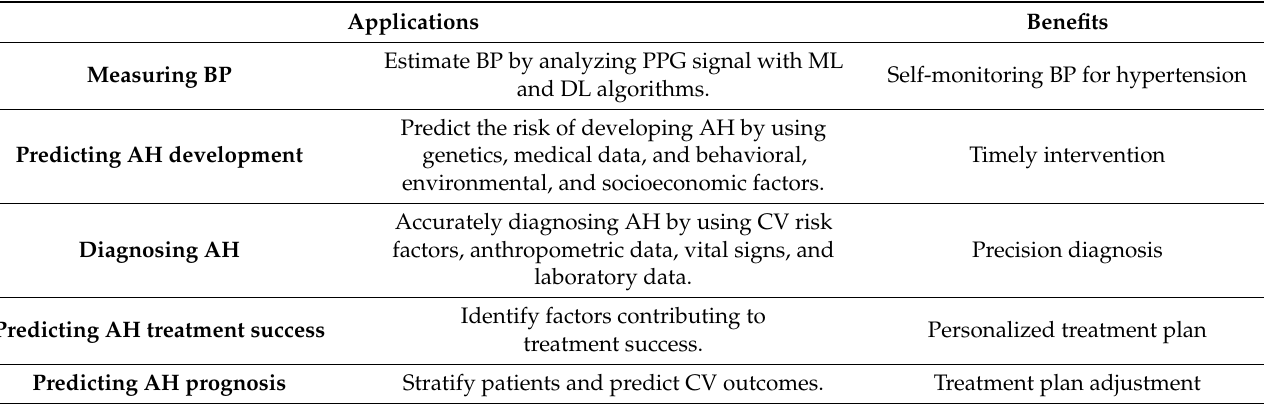
Table 1. AI application in hypertension